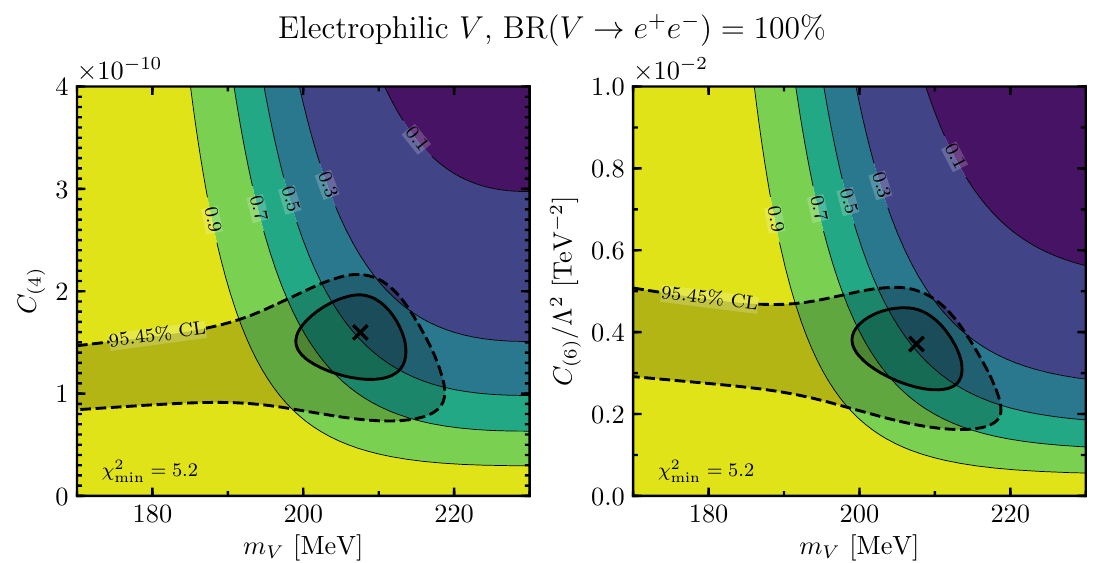
Figure 6 . Contours of the values of R K for an electrophilic V , i.e., BR( V ! e + e (cid:0) ) = 100%, as a function of the Wilson coe(cid:14)cients C Superimposed is the best-(cid:12)t region from the measurement of R K (cid:3) and the electron distribution. We do not show the corresponding case for Q unobservably